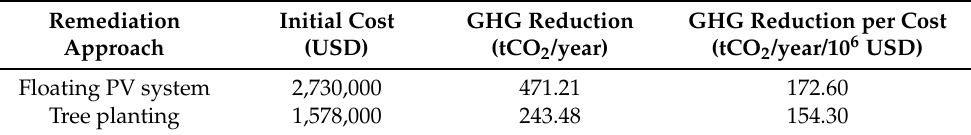
Table 8. Comparison of costs and greenhouse gas reductions of floating photovoltaic system and tree